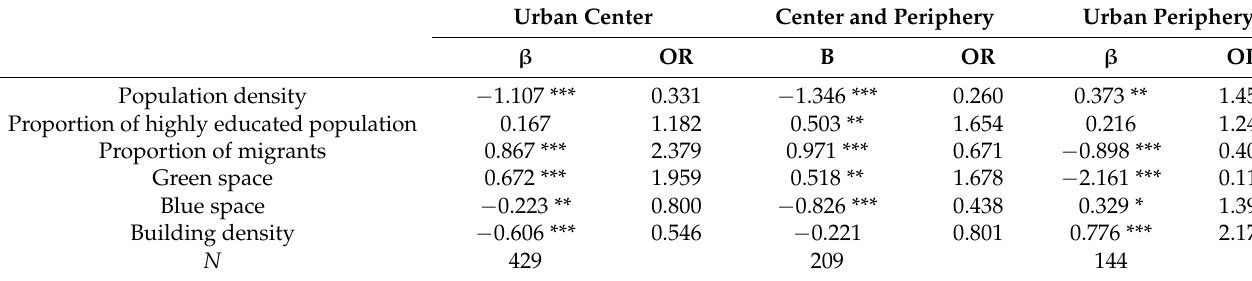
Table 4. Moderating effect of residential location.